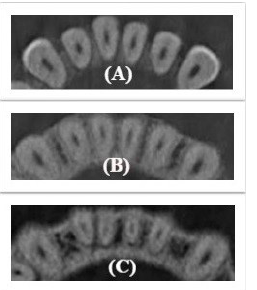
Figure 2. Changed cross-sectional root canal shape for mandibular anterior teeth in the middle third. (A) Coronal; (B) Middle; (C) Apical.